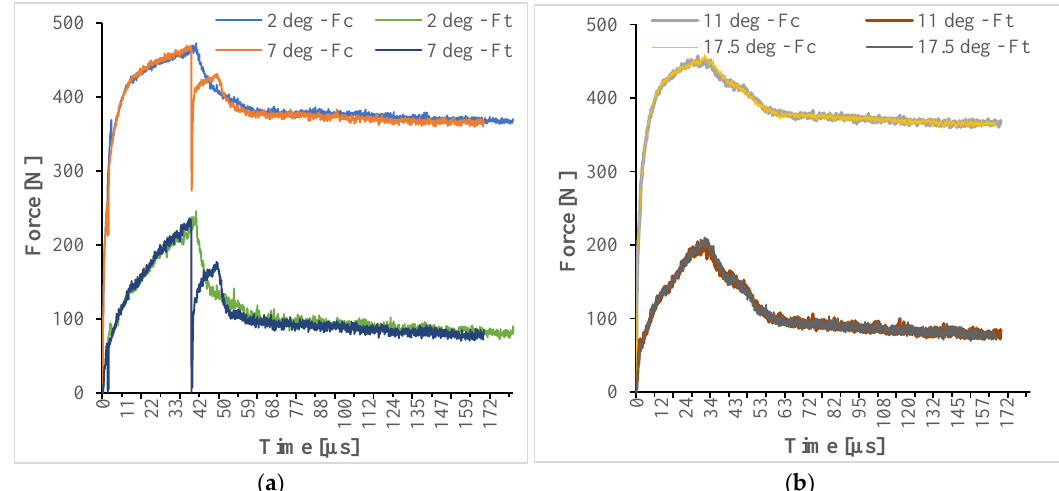
Figure 18. Force distribution during cutting process for different clearance angles (α = 7° and γ =